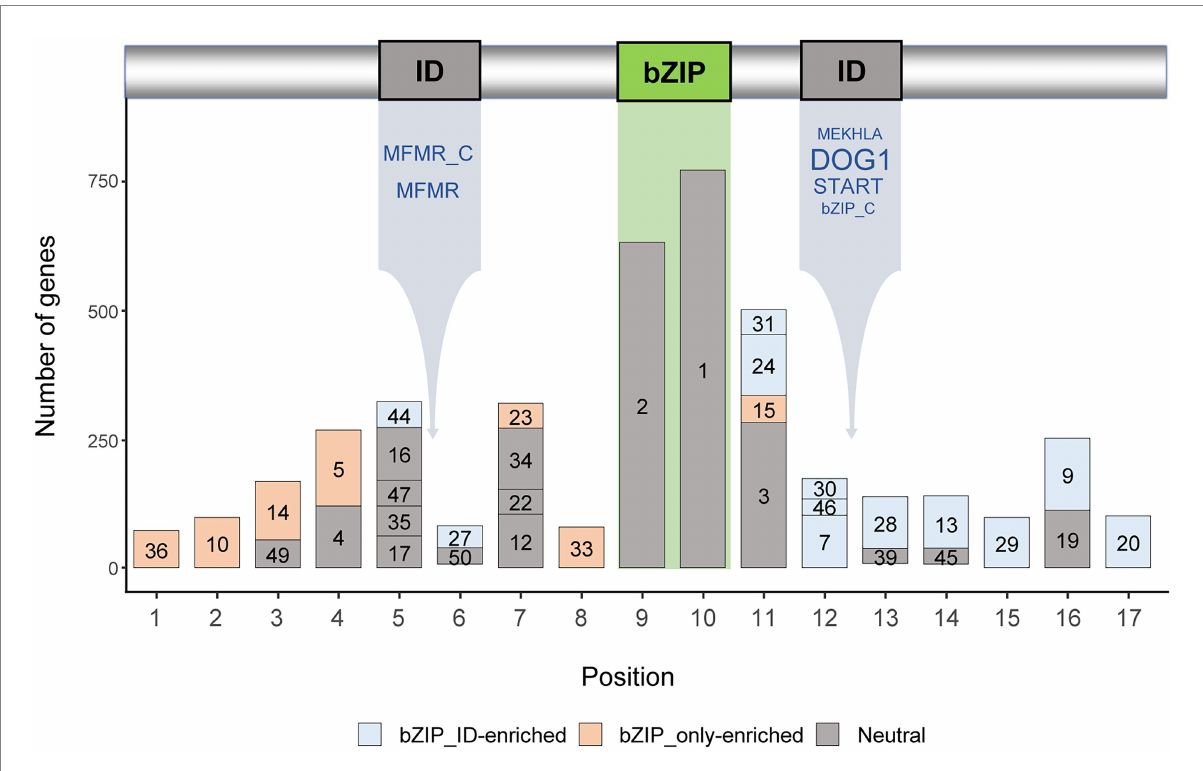
FIGURE 2 Motif compositions of the top five domain architectures of bZIP genes. The numbers in the bars indicate motif labels as described in Supplementary Table 2. The types of integrated domains are listed below the ID box. The font sizes of the names of integrated domains represent the number of domains. Bar colors represent bZIP_only-enriched, bZIP_IDs-enriched, or neutral ( p <